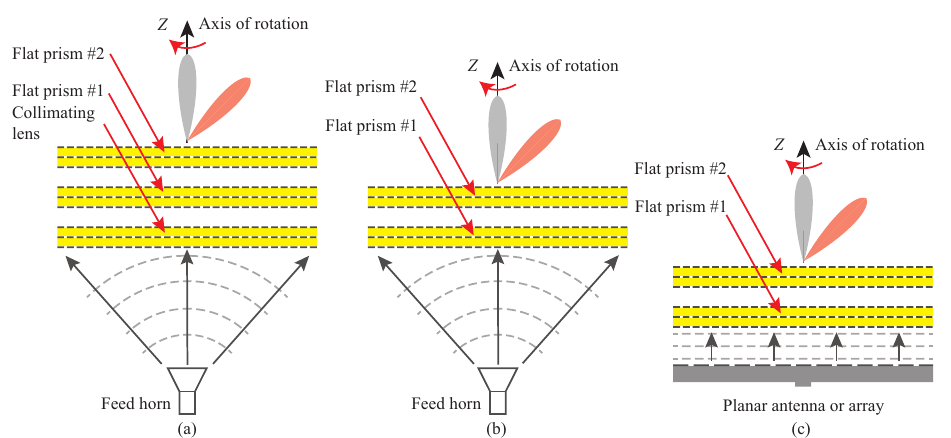
Figure 5. Different configurations of the Risley-prism-based beam-steerable antenna system reported in the literature. ( a ) A system employing a feed horn, a collimating lens and two flat prisms (used in [20]). ( b ) The system in part ( a ) in which the collimating lens are integrated with the first prism (used in [20–22,26]). ( c ) The system in part ( a ) in which the horn antenna is replaced with a planar antenna or antenna array placed in close proximity to the two flat prisms (used in [23,24]). In such a system, a collimating lens is not needed.